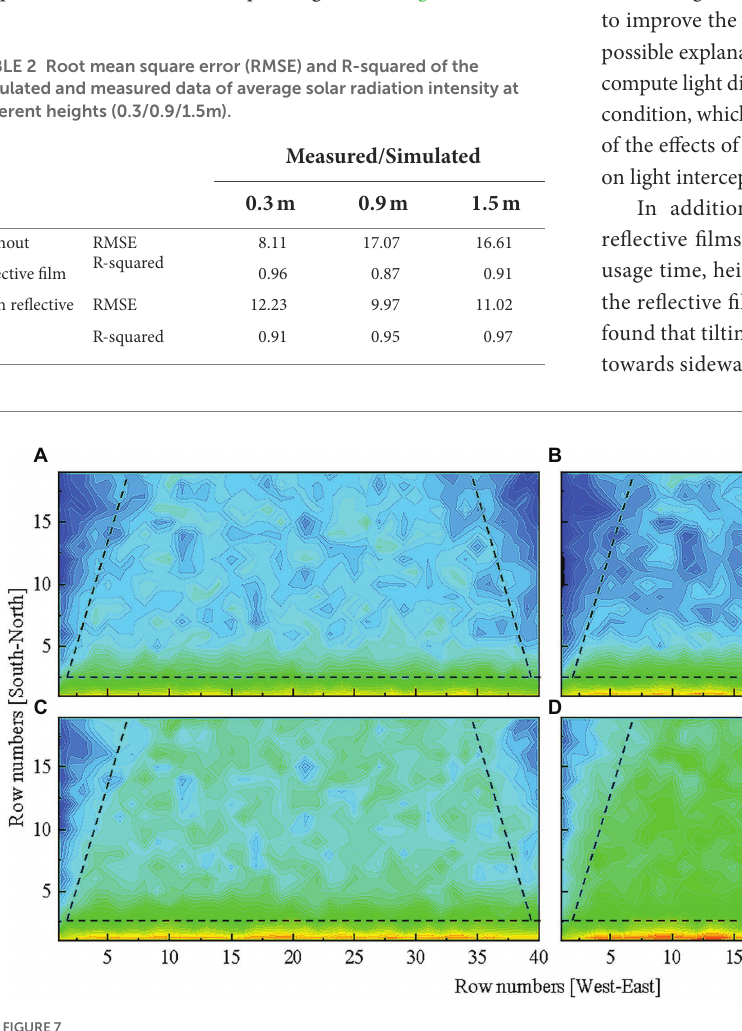
FIGURE 7 Total tomato canopy light distribution in a solar greenhouse on (A) November 6th, (B) December 30th, (C) January 29th, and (D) February 26th. Tomato canopy light interception in different areas of the greenhouse is separated by dashed lines for